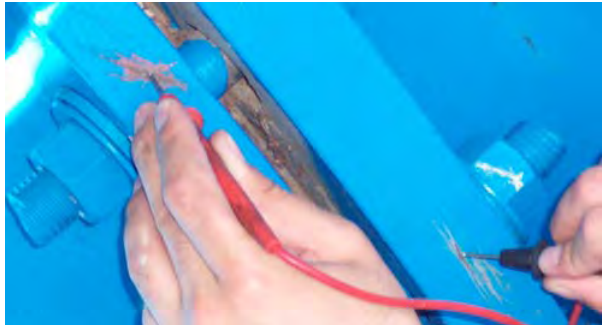
Figure 5. Electrical insulation test.